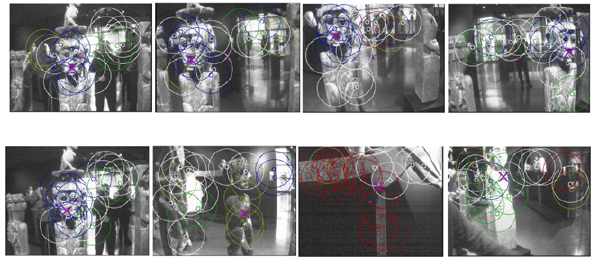
Figure 8: (Top) the object 1 recognition from different angles in test mode. (Bottom) objects recognition in test mode. The circles represent the object’s